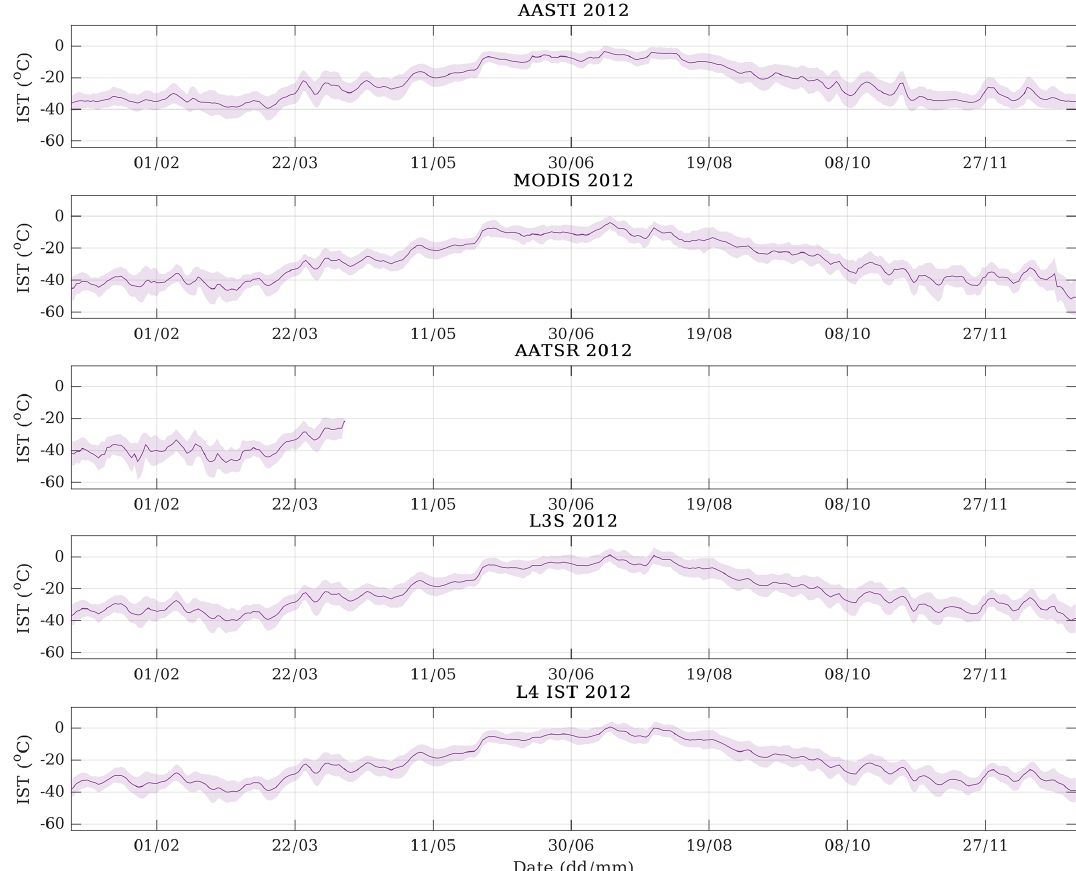
Figure 3. Mean daily IST (solid line) and its standard deviation (shaded area) over the Greenland Ice Sheet from the L3 AASTI, L3 MODIS, L3 AATSR (when available), and derived L3S and L4 IST products. Table 3. Mean annual and seasonal IST with standard deviation ( ◦ C), from the different L3 and the L4 IST products for the Greenland Ice Sheet for 2012. Winter (DJF) Spring (MAM) Summer